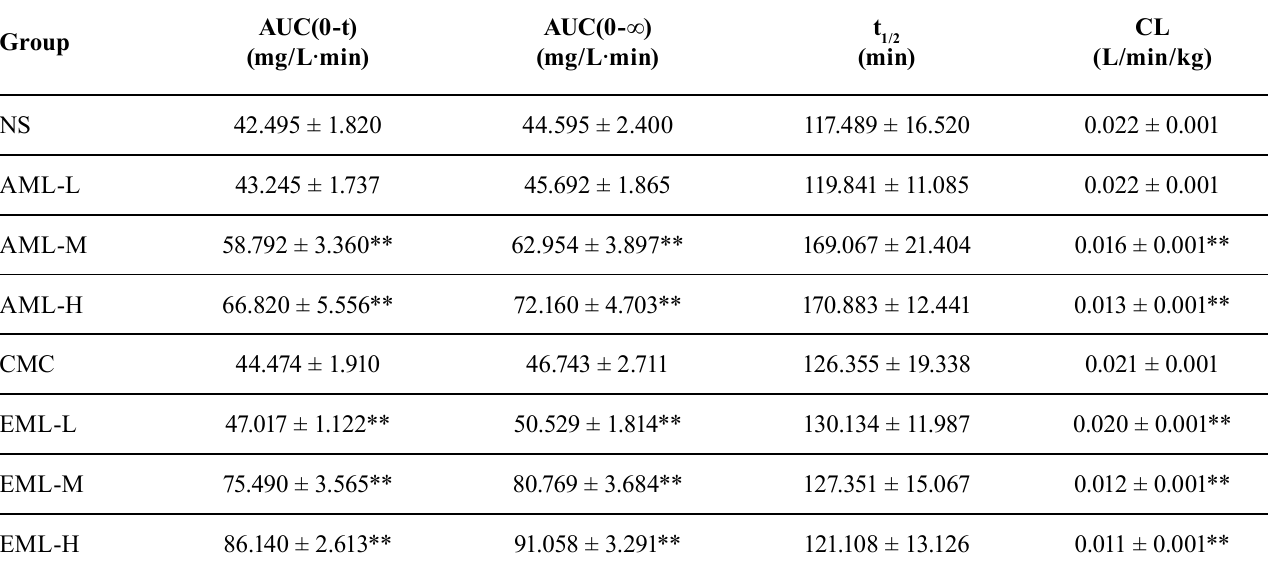
TABLE V – M ain pharmacokinetic parameters of dextromethorphan in rats (n=6, mean ± SD)